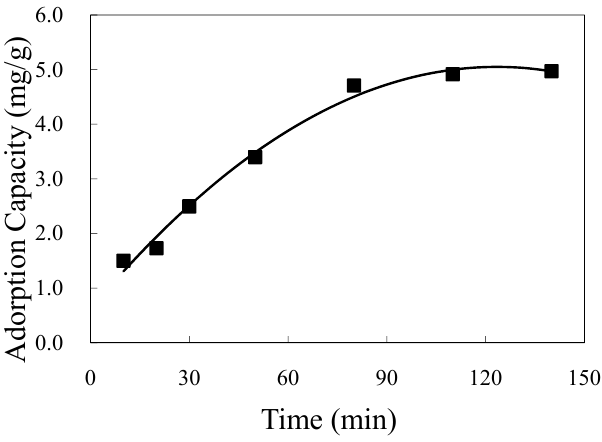
Figure 4. Adsorption kinetic of mogroside V on HZ 806 at 25